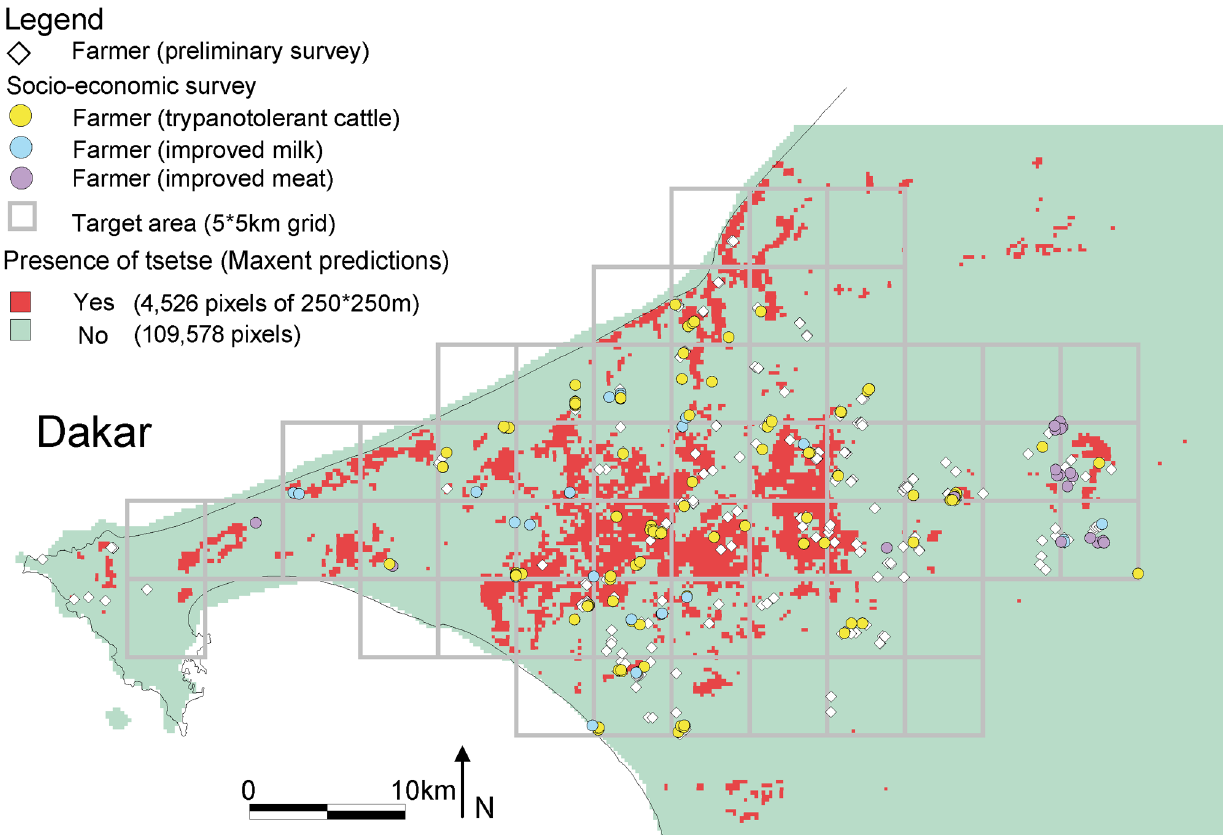
Figure 1. Location of the study area, between Dakar and Thie`s, Senegal. The grid corresponds to 5*5 km cells that were used to design the entomological sampling strategy during the feasibility study [14]. Pixels that could harbor Glossina palpalis gambiensis as predicted by the Maxent model are coloured in red. White lozenges correspond to the livestock farms geo-referenced during the preliminary survey whereas circles correspond to the farms surveyed during the socio-economic survey (see text for details).